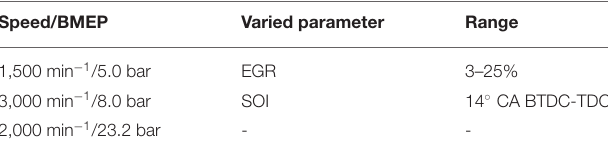
TABLE 1 | Operation points, varied parameters, and their